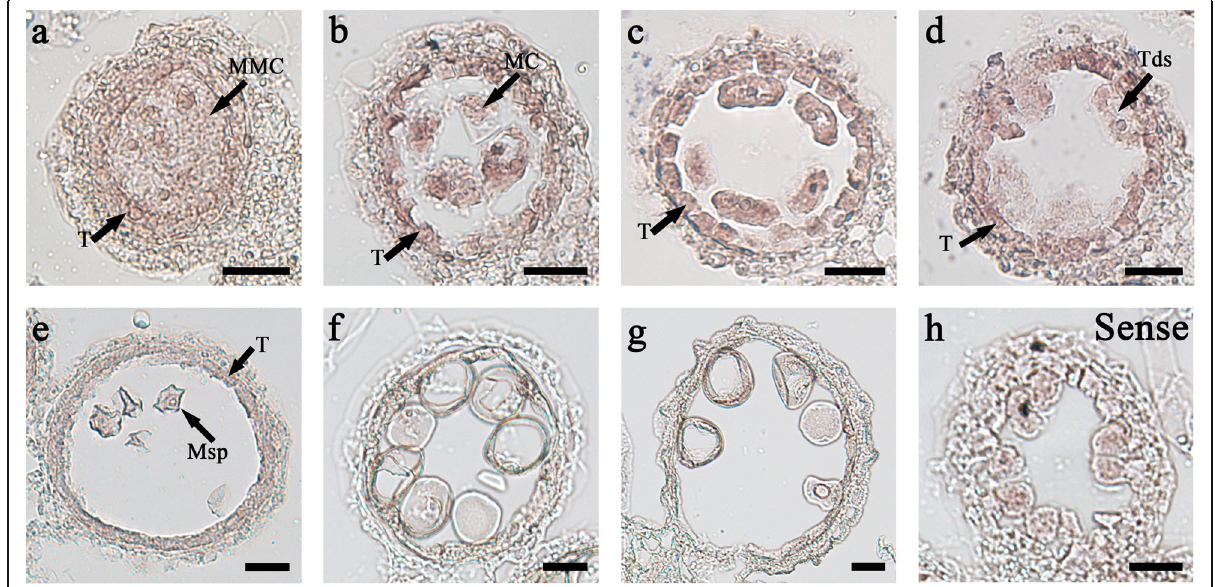
Fig. 4 In situ analysis of OsMS188 expression in wild-type anthers at different developmental stages. In situ hybridization of OsMS188 transcripts at stage 6 ( a ), stage 7 ( b ), stage 8a ( c ), stage 8b ( d ), stage 9 ( e ), stage 10 ( f ) and stage11 ( g ) anthers with an OsMS188 antisense probe. The anthers at stage 8b ( h ) hybridized to an OsMS188 sense probe. MMC, microspore mother cell; MC, meiotic cell; Msp, microspore; T, tapetum; Tds, tetrads. Bars = 20 μ